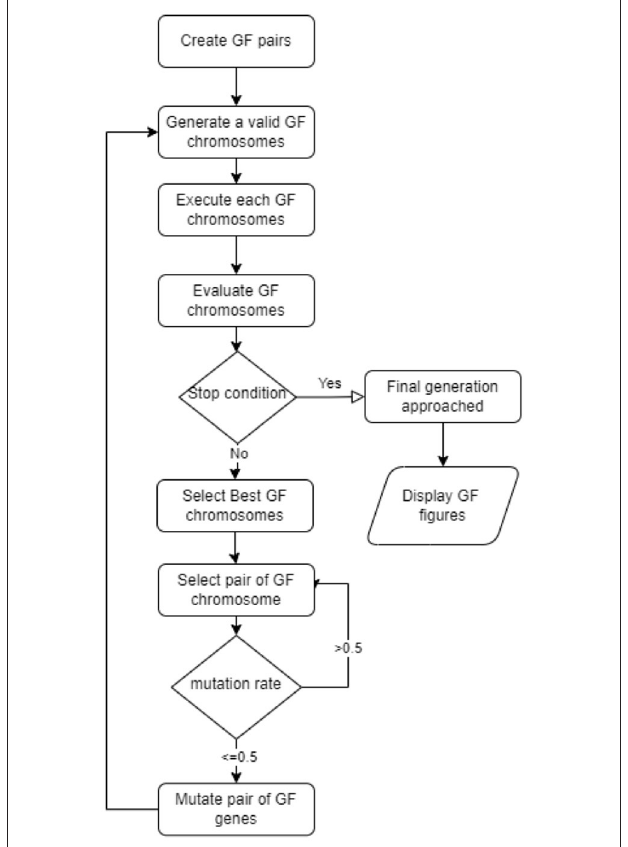
FIGURE 1 | GF life cycle.